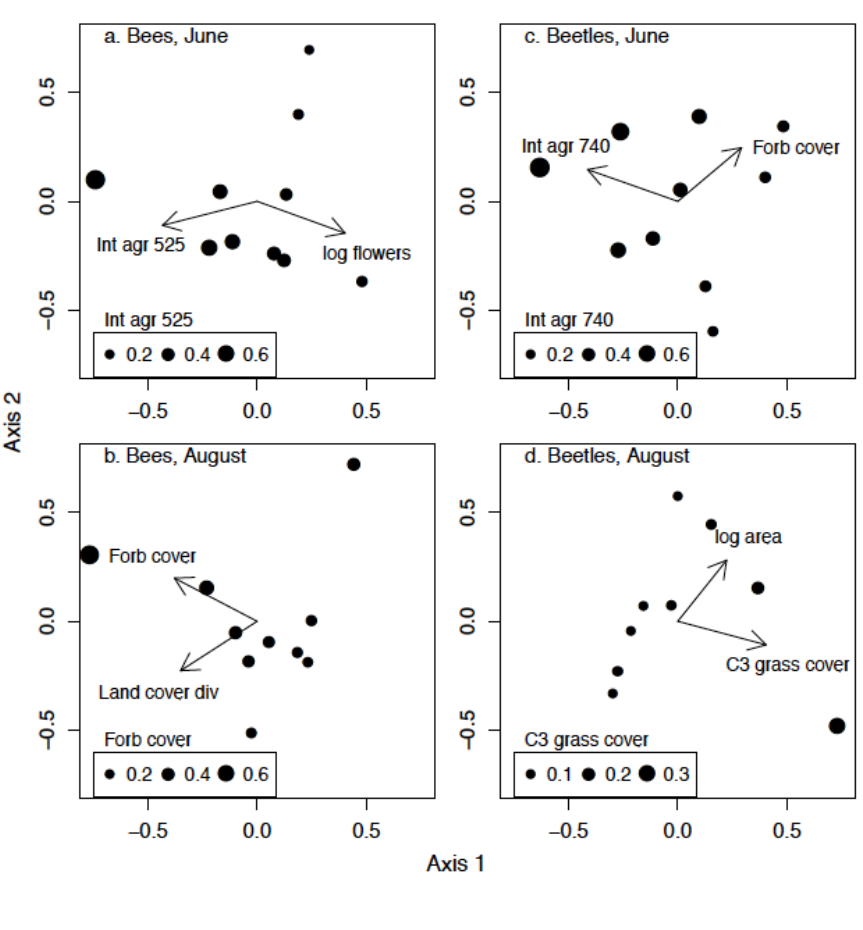
Figure 6. Multivariate ordinations of bee and beetle community composition across the 10 conservation grasslands using distance-based redundancy analysis and Bray-Curtis dissimilarity. Symbols indicate site scores of grassland patches, and are sized proportional to the value of the most important predictor variable. Arrows are biplot correlations of the significant predictor variables. ( a ) bees in June ( b ) bees in August ( c ) beetles in June ( d ) beetles in